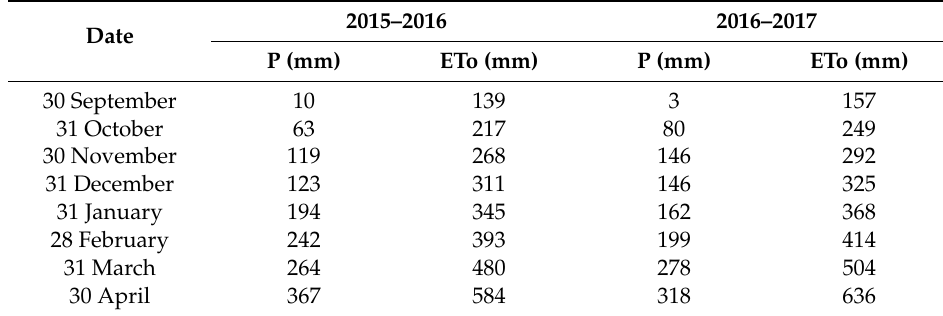
Table 1. Cumulative monthly precipitation and evapotranspiration (ETo) (mm) during the two agricultural seasons in which the study was carried out. The precipitation (P) was the average recorded in the two olive orchards evaluated, and the ETo was obtained from the Santaella agro-meteorological station.